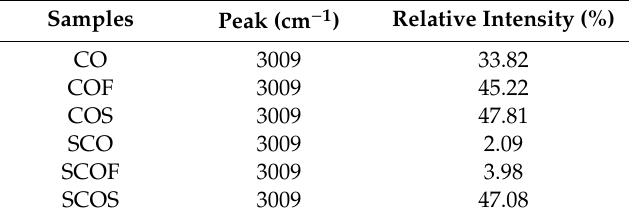
Table 2. Quantitative data for FT-IR spectrogram of the related samples (m S : m COX = 1:1).